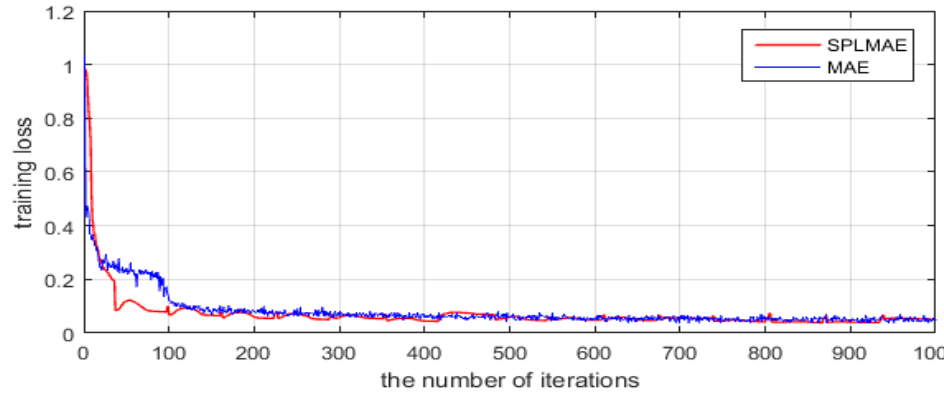
Figure 7. The convergence analysis of the Flevoland dataset from RADARSAT-2. Table 2. The accuracies of Flevoland dataset from RADARSAT-2. AA: average accuracy; OA: overall accuracy.